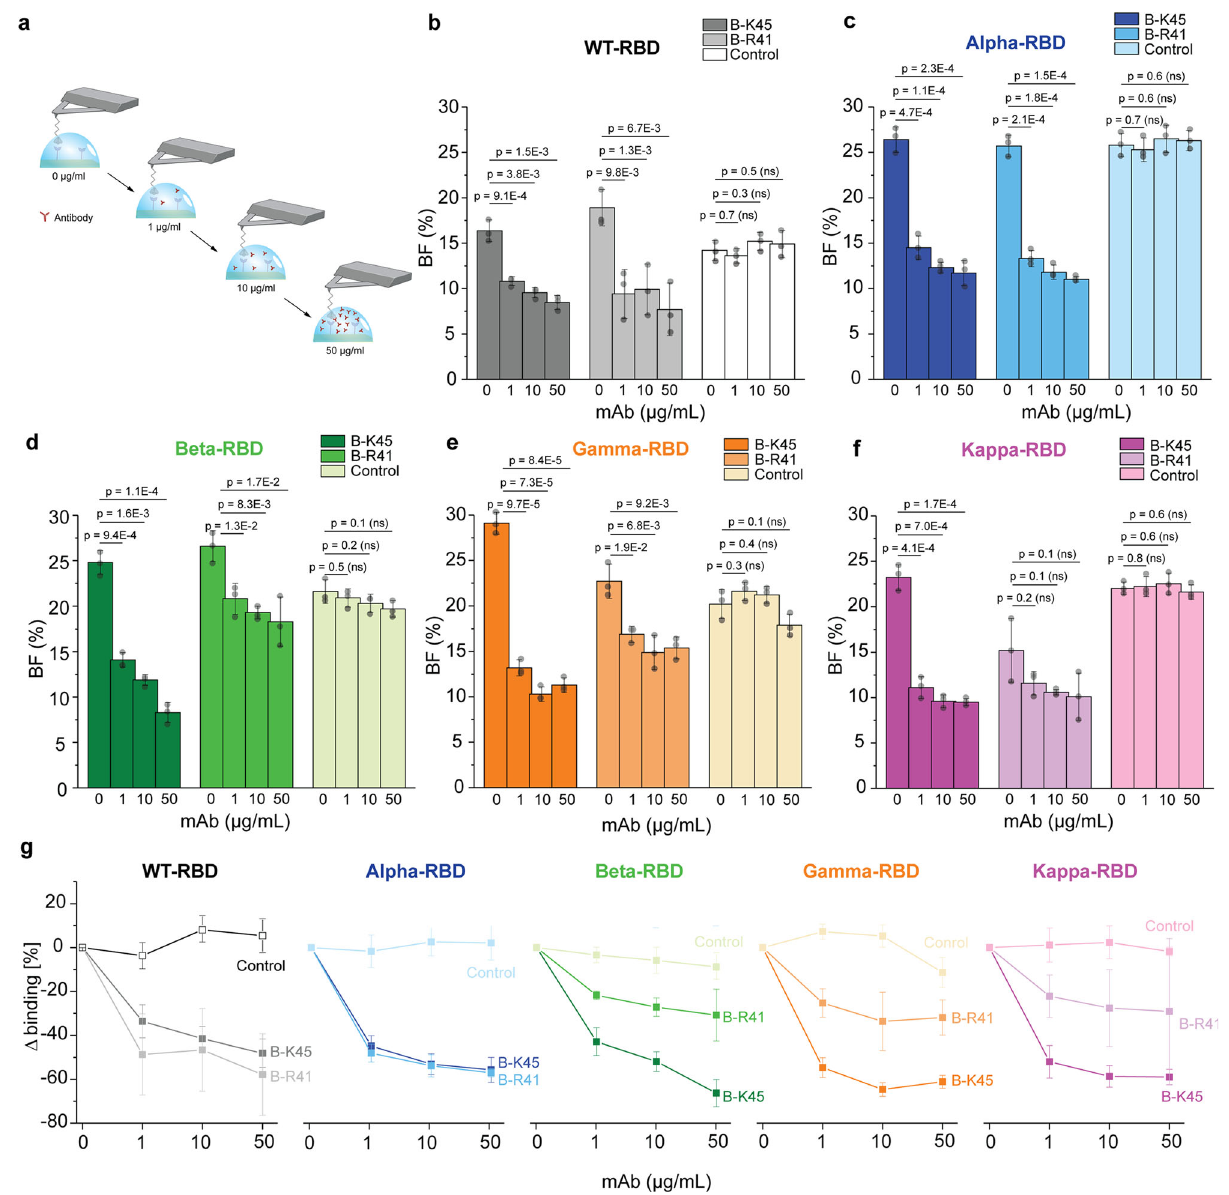
Fig. 6 Probing antibody ef fi ciency to inhibit binding of the different RBD mutants to ACE2 receptor. a Ef fi ciency of blocking antibodies is evaluated by measuring the binding frequency of the interaction between ACE2 and the RBD mutants before and after incubation with the three different monoclonal antibodies (mAbs) at increasing concentration (1 – 50 µ g mL − 1 ). b – f Histograms, with individual data points overlaid [ N = 3 independent experiments (tips and sample)], showing the binding frequency of the interaction between ACE2 and WT-RBD ( b ), Alpha-RBD ( c ), Beta-RBD ( d ), Gamma-RBD ( e ) or Kappa- RBD ( f ) without mAb and upon incubation with 1, 10, or 50 µ g mL − 1 of two monoclonal anti-RBD (B-K45 and B-R41) or a control IgG1 isotype mAb. g Graph showing the reduction of the binding frequency. Data are representative of at least N = 3 independent experiments (tips and sample) per mAb concentration. P -values were determined by two-sample t-test in Origin. The error bars indicate s.d. of the mean value. WT-RBD is colored in gray/black, and the VoCs Alpha-RBD in blue, Beta-RBD in green, Gamma-RBD in orange, and Kappa-RBD in